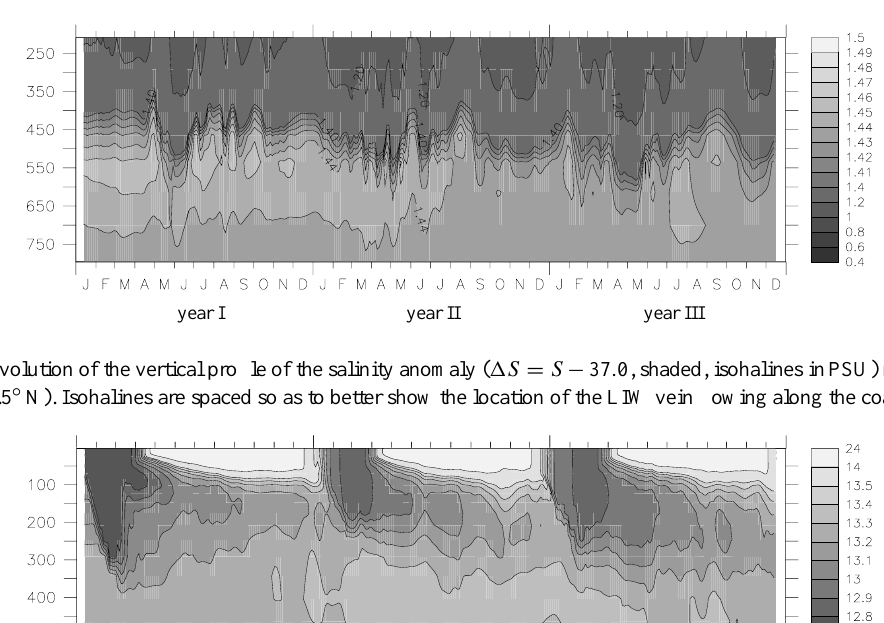
years II and III in the RM (Fig.